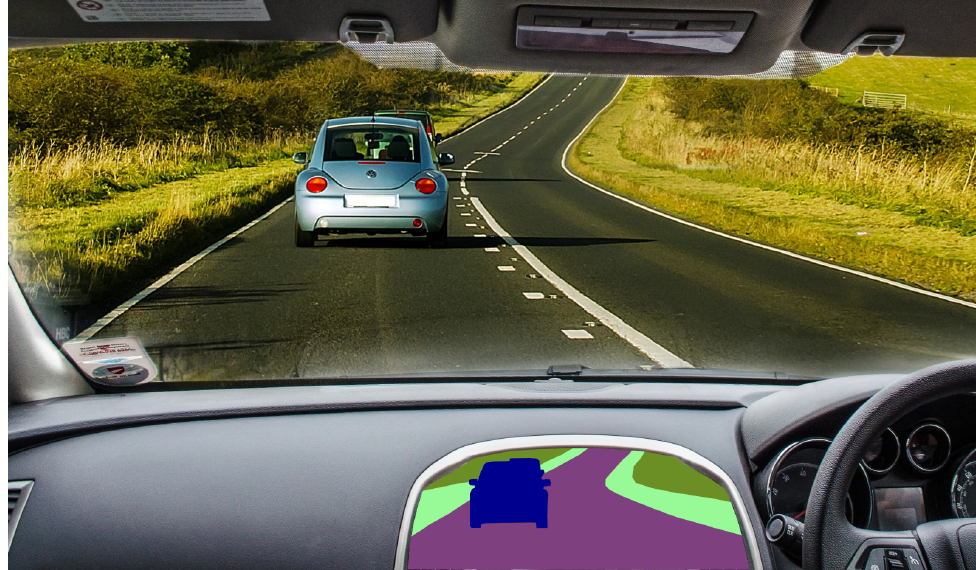
Figure 1. The car screen shows an example of semantic segmentation of the scene in front of the car. Early approaches to semantic segmentation were based on the use of classifiers on small image patches [11–13], until the introduction of deep learning, which has enabled great improvements in this field as